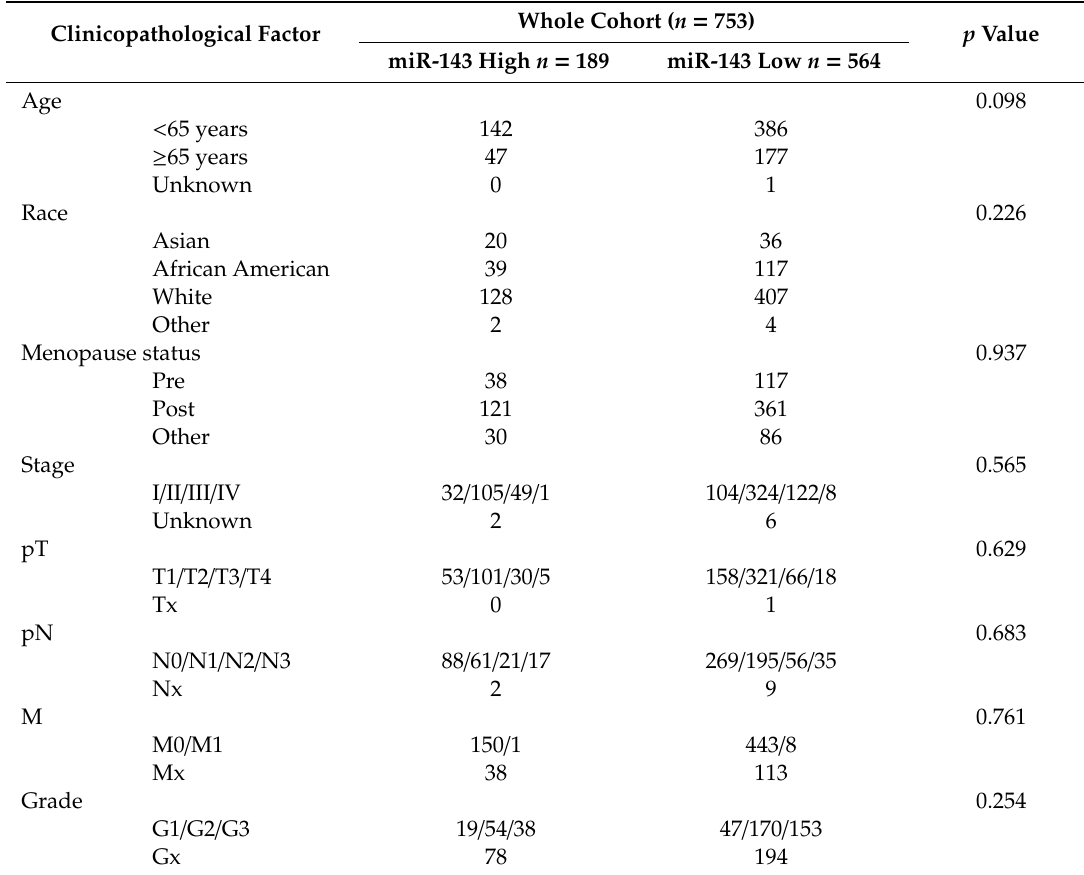
Table 1. Clinicopathological demographics of the miR-143 High and miR-143 Low